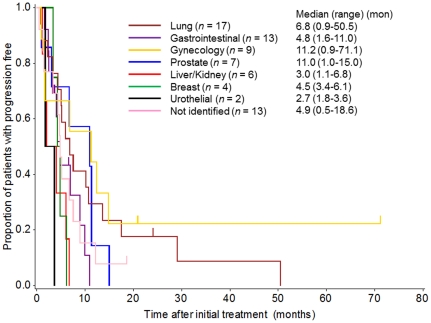
Progression-free survival curve by the Kaplan-Meier method for the groups with each primary site as classified by the immunohistochemistry profiles.